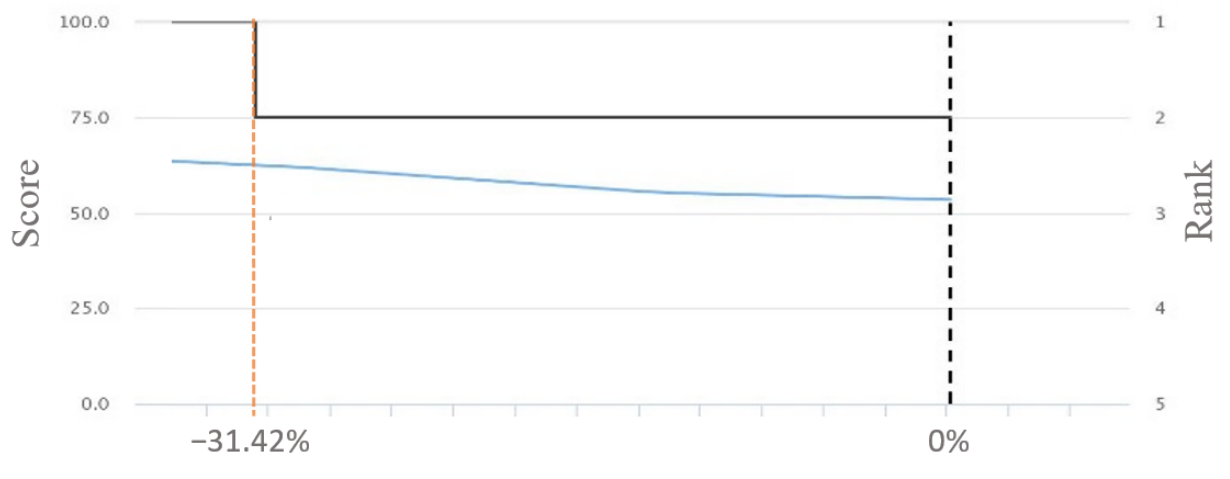
Figure 8. Changes in PROMETHEE ranking of supplier S1 when its cost is Figure 8 . Changes in PROMETHEE ranking of supplier S1 when its cost is modified.